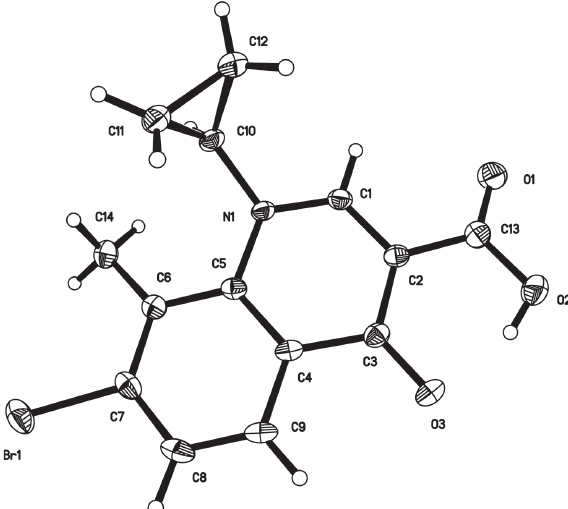
Table 1: Data collection and handling.